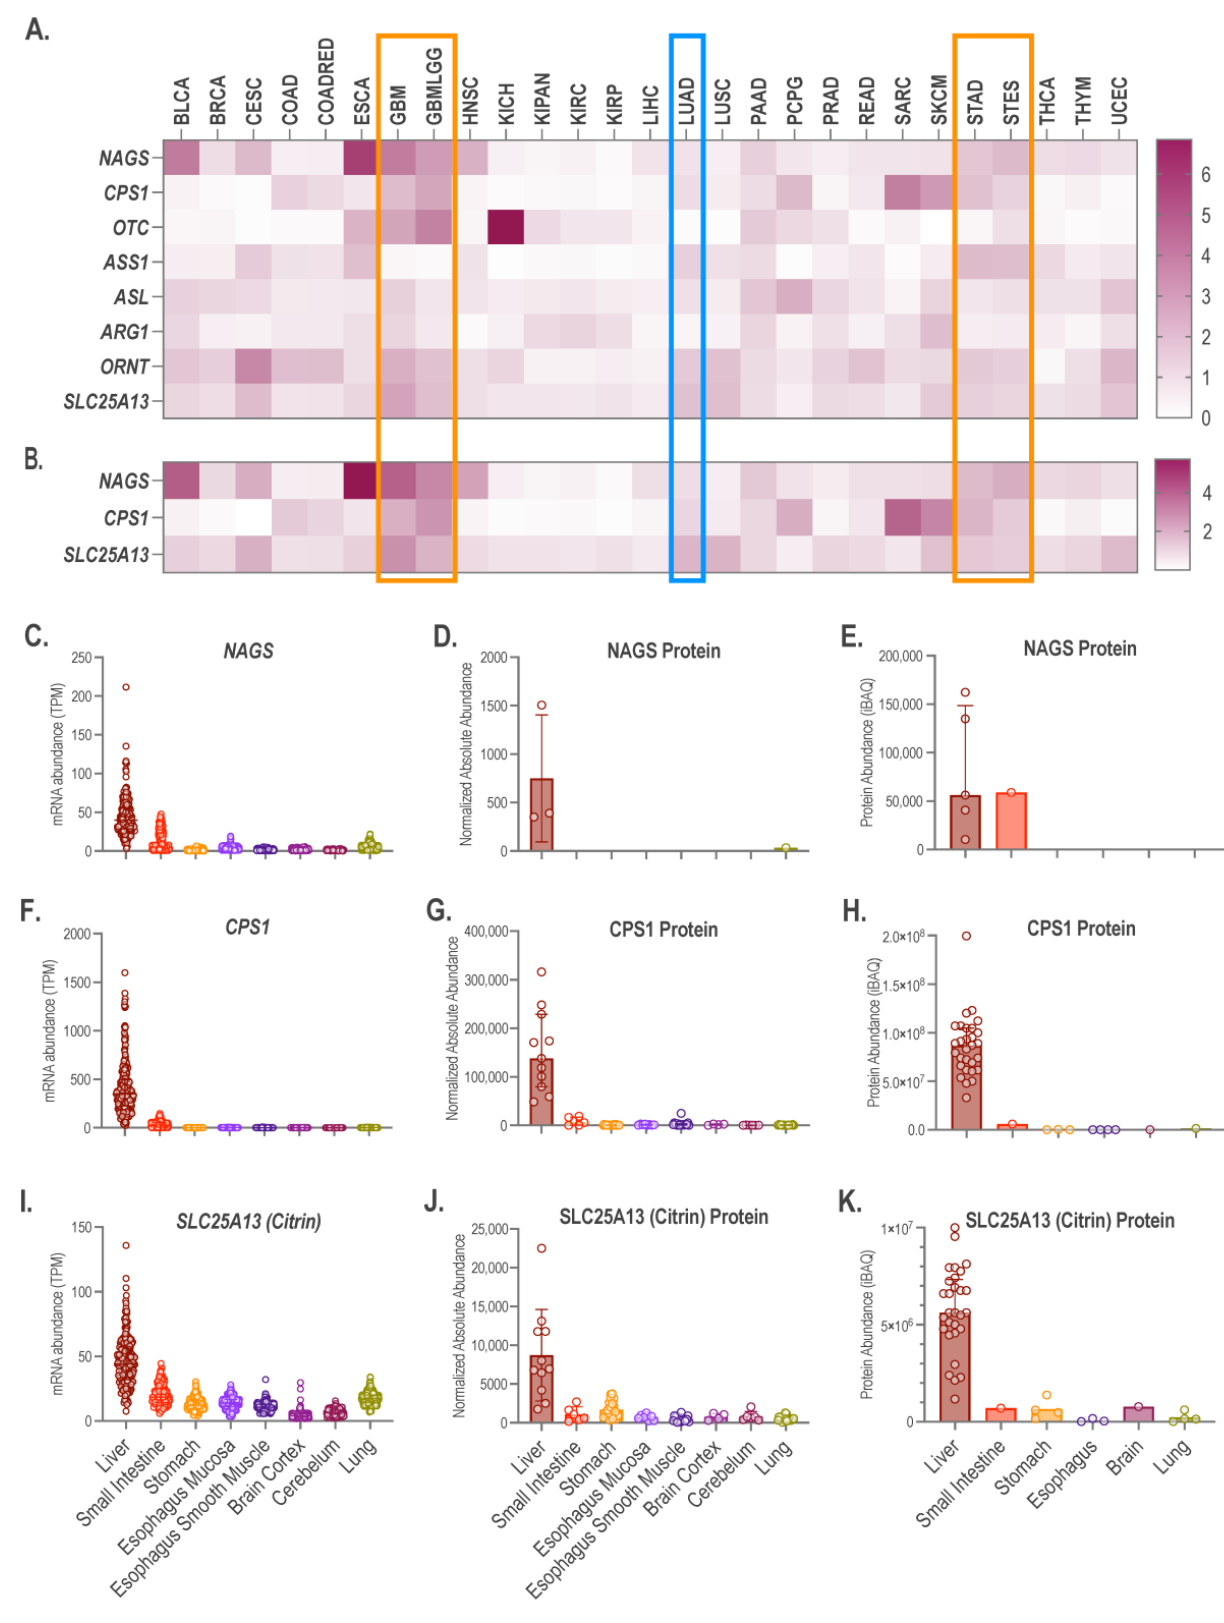
Figure 1. Expression of urea cycle genes in tumors and normal tissues. Fold-change of the median mRNA expression of all eight urea cycle genes ( A ) and NAGS, CPS1 and citrin mRNA ( B ) in tumor samples and the matched normal tissues. Depending on the tumor type, the number of tumor sam- ples considered here was between 36 and 1100. Orange boxes — tumors that overexpress NAGS , CPS1, and citrin. Blue box — lung adenocarcinoma overexpressing citrin. Urea cycle gene symbols: NAGS – N-acetylglutamate synthase; CPS1 – carbamylphosphate synthetase; OTC – ornithine transcar-